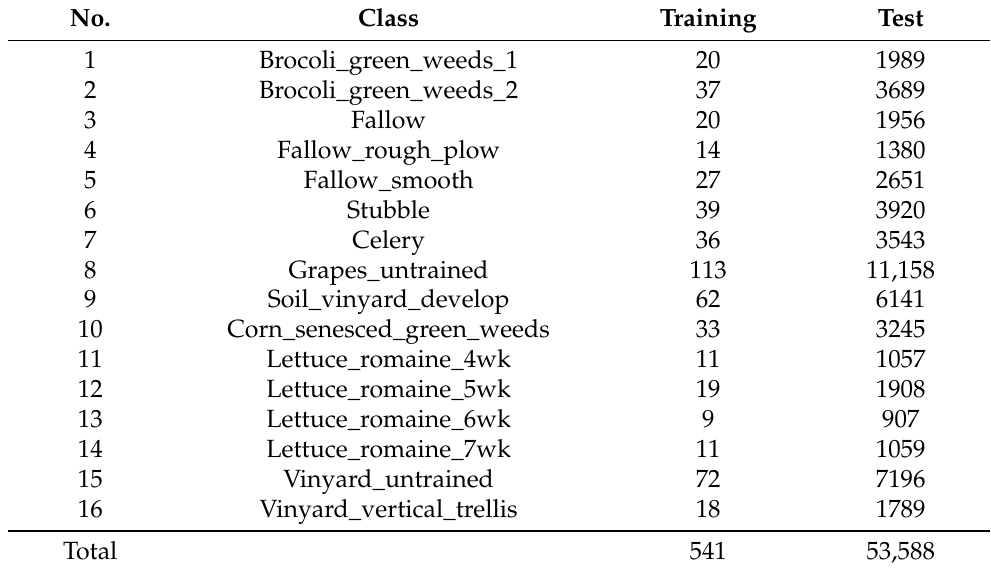
Table 3. Training and testing data in the Salinas data